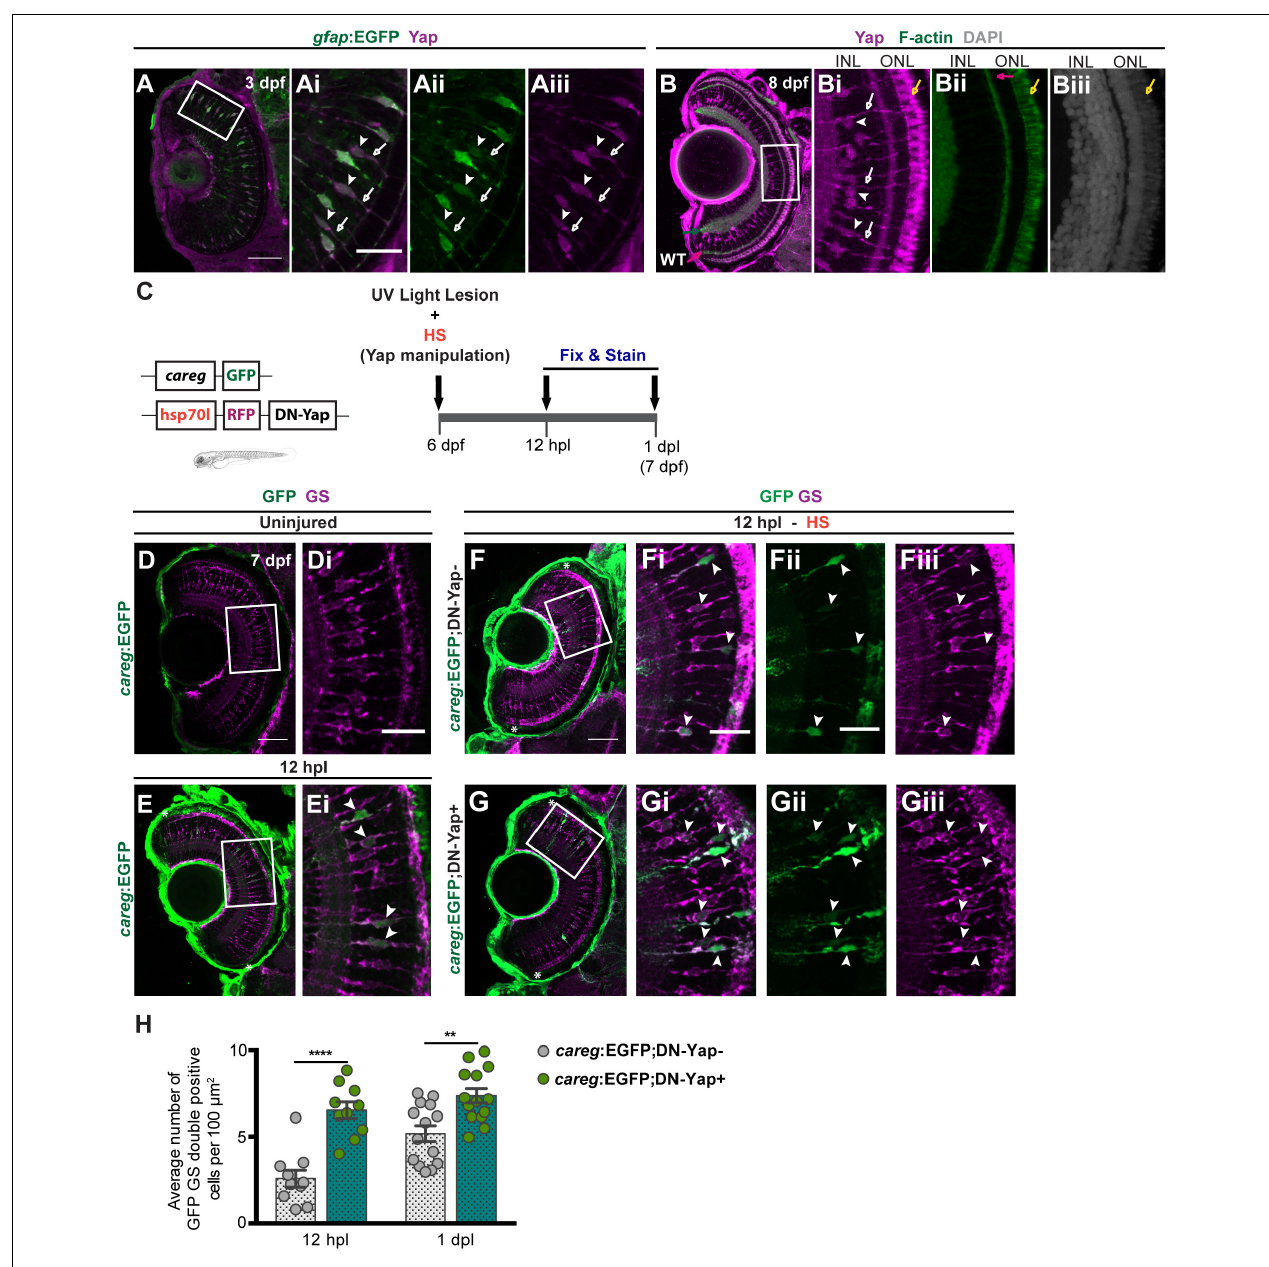
FIGURE 1 | Yap inhibition induces accumulation of activated Müller glial cells (MGs) upon photoreceptor-induced light lesion. (A) Transverse cryosection of a Tg( gfap :GFP) 3-dpf retina immunostained for green fluorescent protein (GFP) (green, Ai ) and Yap (magenta, Aii ), indicating Yap localization in MG cell bodies (arrowheads) and radial processes (arrows) (Ai–Aiii) . (B) Transverse cryosection of a WT 8-dpf retina immunostained for Yap (magenta, B,Bi ) and F-actin (green, B,Bii ) and counterstained with DAPI (gray, Biii ), indicating photoreceptors outer-segment autofluorescence (yellow arrow). (C) Schematic representation of the UV light lesion assay. (D,E) Transverse cryosections of uninjured 7-dpf careg -EGFP (D,Di) and 12-hpl careg -EGFP (E,Ei) larva retinas immunostained for GFP (green) and glutamine synthetase (GS) (magenta). White arrowheads indicate GFP-positive MGs activating careg ( E , magnified, Ei ). (F,G) Transverse cryosections of 12-hpl careg :EGFP;DN-Yap − controls (F-Fiii) and careg :EGFP;DN-Yap+ (G-Giii) retinas immunostained for GFP (green) and GS (magenta). White arrowheads indicate GFP-positive MGs activating careg . (H) Quantification of the number of double GFP GS-positive cells in careg :EGFP;DN-Yap − controls and careg :EGFP;DN-Yap + larva retinas from 12 hpl to 1 dpl. ** p < 0.01, **** p < 0.0001; unpaired t -test with Welch’s correction. White boxes delimitate magnified (Ai–Giii) . Green arrow indicates the inner plexiform layer. Pink arrow indicates the outer plexiform layer. Scale bars correspond to 50 µ m in (A,D,F) and 20 µ m in magnified (Ai,Di,Fi) . Asterisks delimitate the lesioned region.